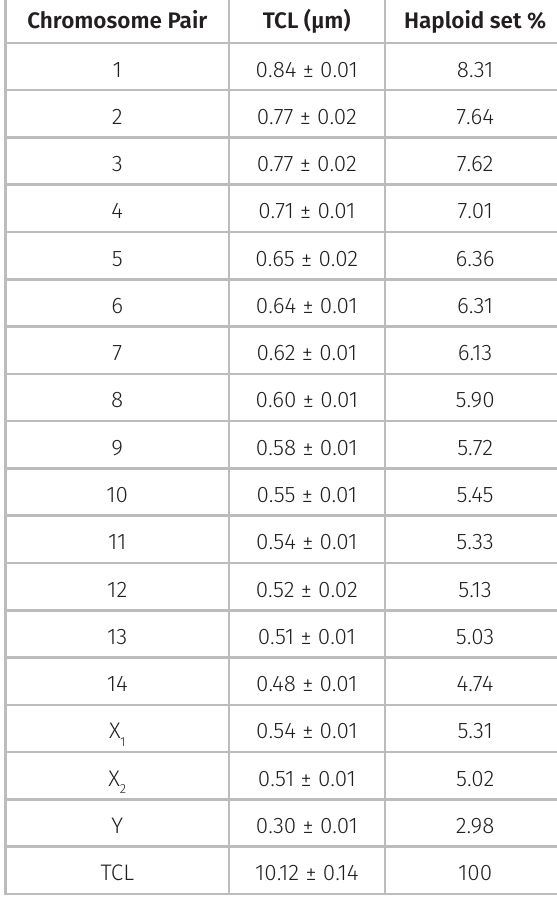
Table II. Total meiotic chromosome lengths (TCL) of Cyanolicimex patagonicus (mean ± SE) in the haploid